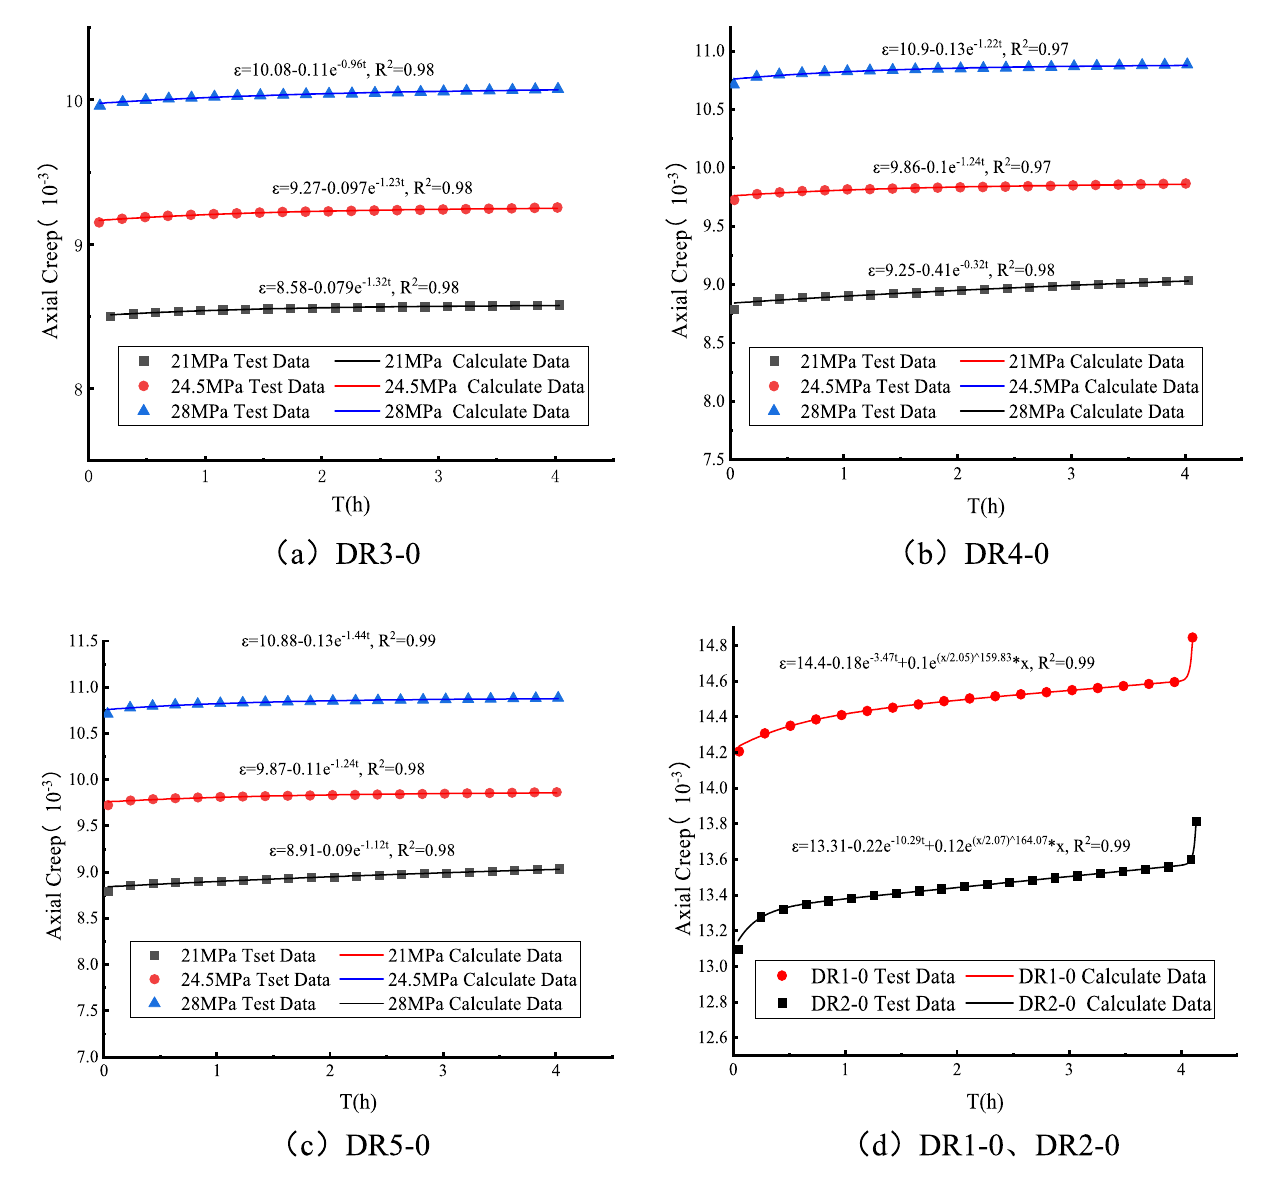
Figure 18. Comparison between experimental data of white sandstone and theoretical